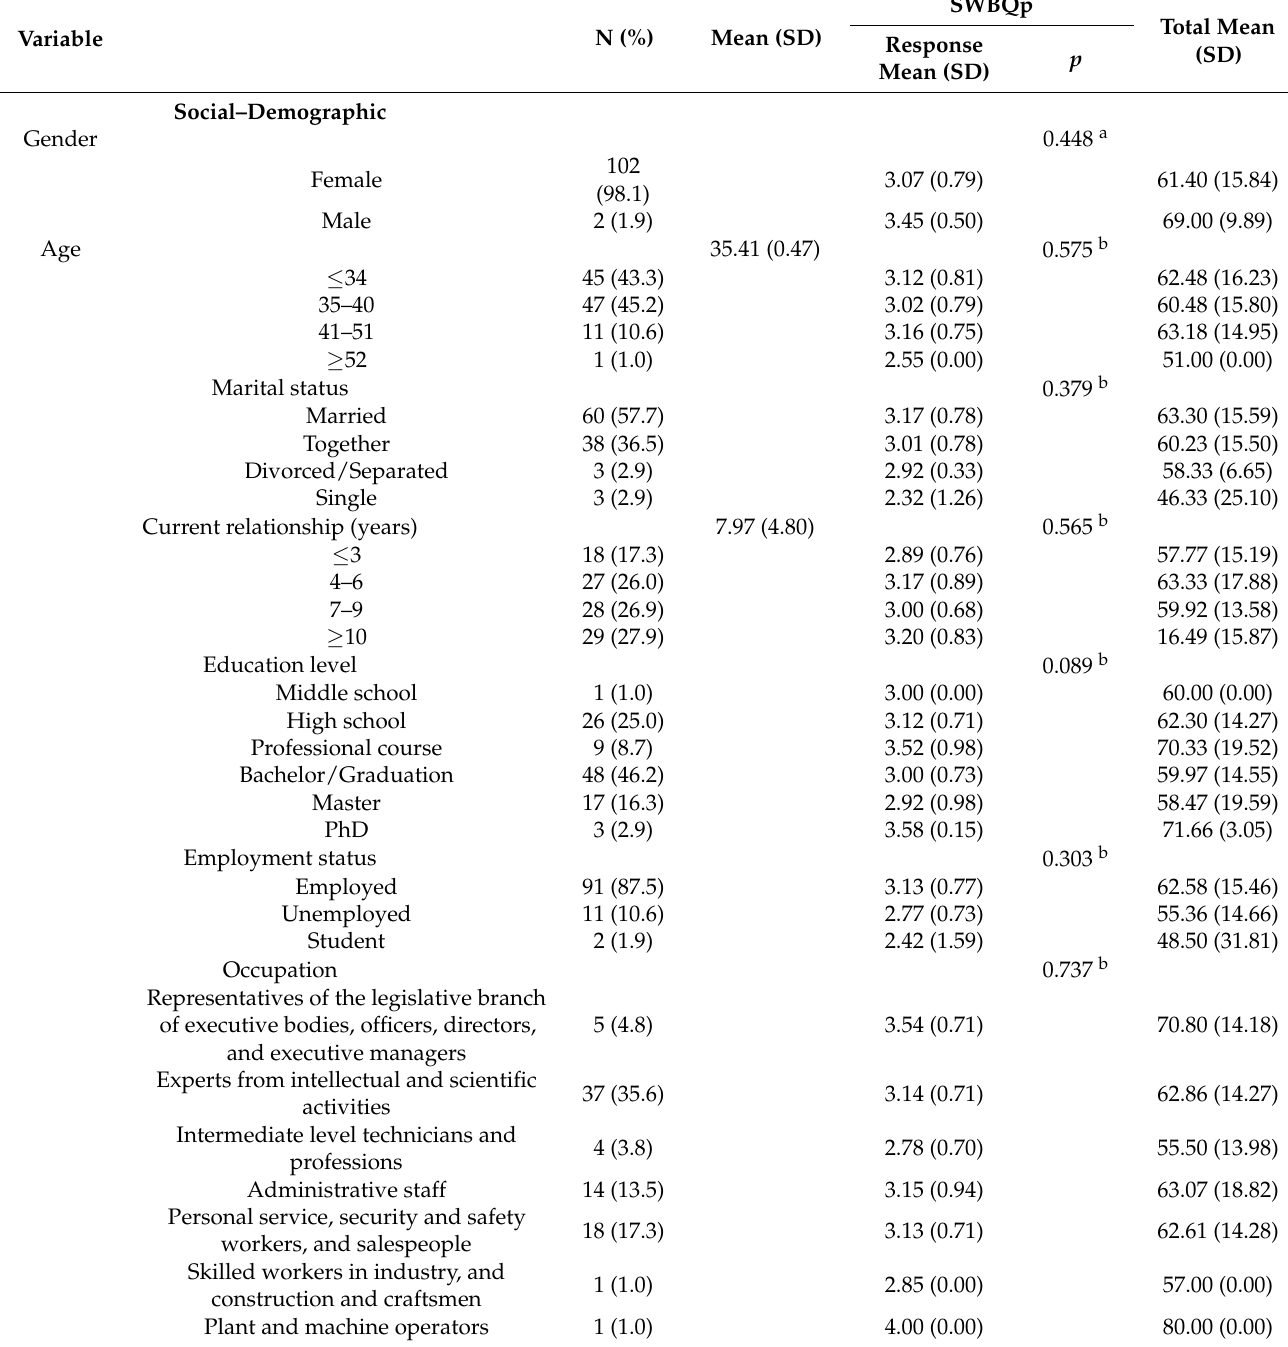
Table 1. Characteristics of participants and mean scores of the SWBQ ( N =